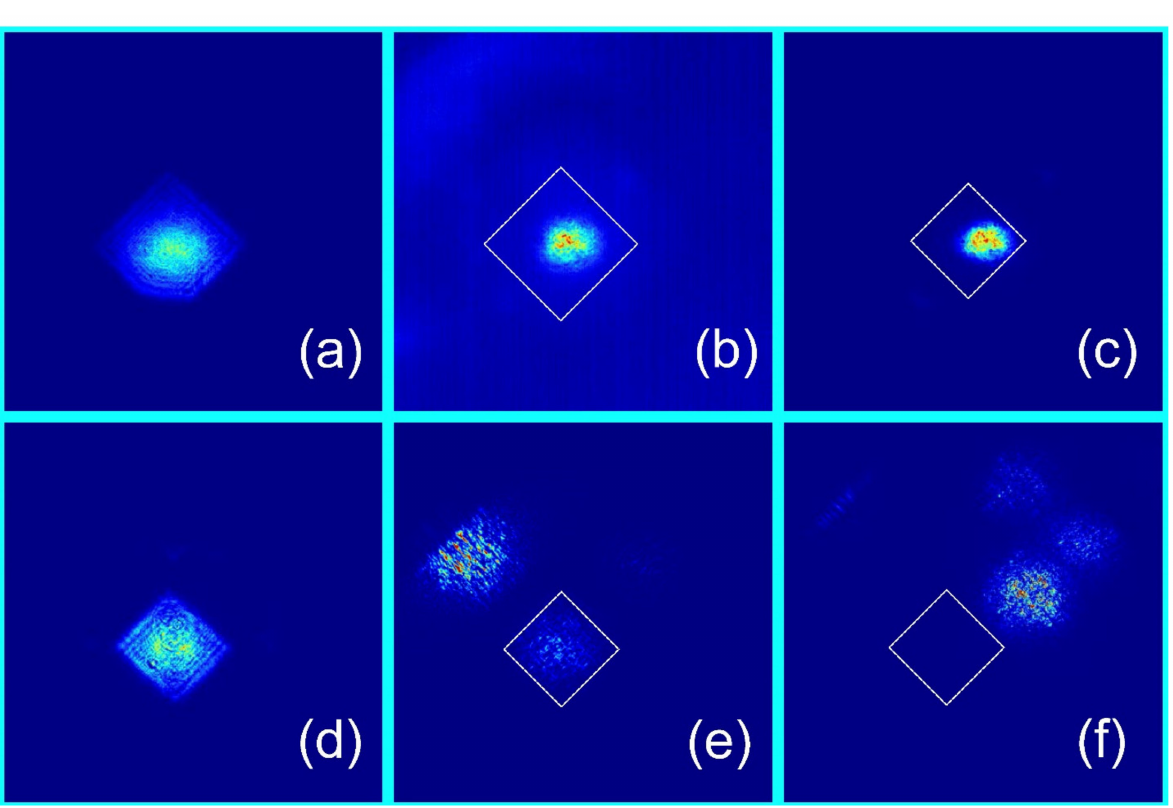
Figure 4. Fundamental radiation and harmonics intensity distributions on a matrix sensor located 20 cm behind PCs: ( a ) Fundamental radiation in X-cut KTP PC; ( b ) TH in X-cut KTP PC; ( c ) TH in Y-cut KTP PC; ( d ) fundamental radiation in RTP PC; ( e ) SH in Y-cut RTP; ( f ) TH in Y-cut RTP. Dotted quadrate counter lines indicate the projection of the PC aperture on the matrix sensor plate for the harmonics beam’s observation.